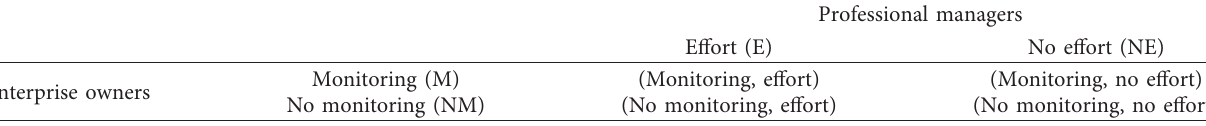
Table 1: The strategy of enterprise owners and professional